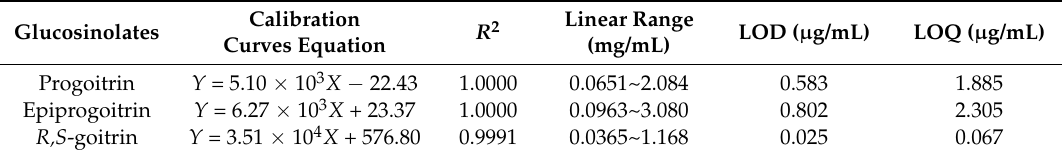
Table 1. Regression equations, linear range, limit of detection (LOD) and limit of quantification (LOQ) for three analytes.